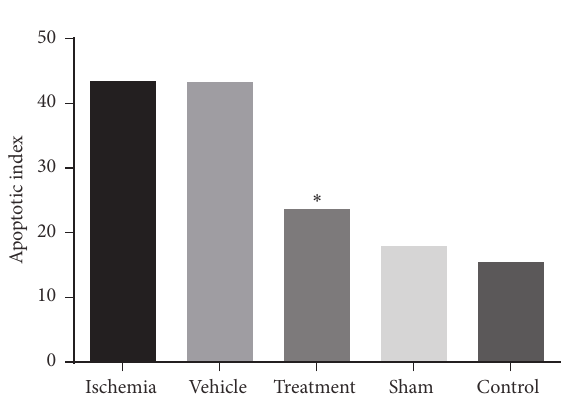
Figure 5: Apoptotic index in different groups. The results revealed that this index was less in the treatment group compared to the ischemia group (shown with ∗ ).